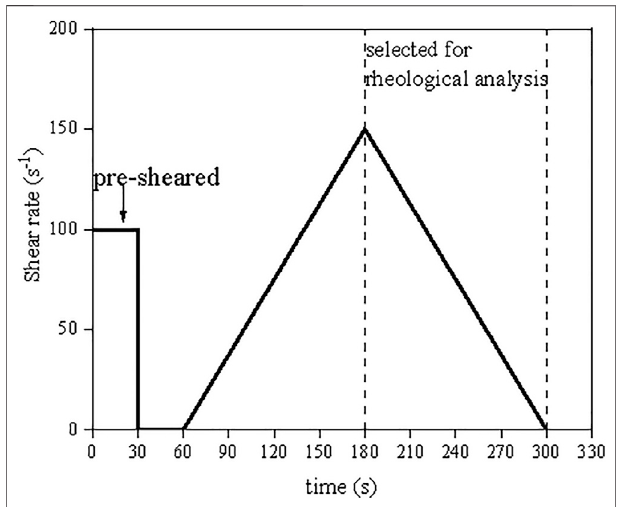
FIGURE 6 | The shear procedure of rheometer.